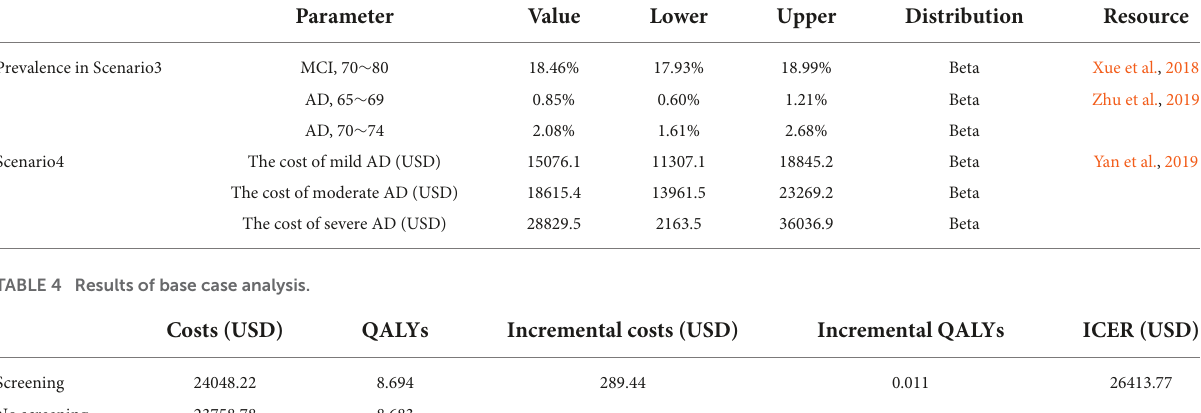
TABLE 3 Scenario inputs.